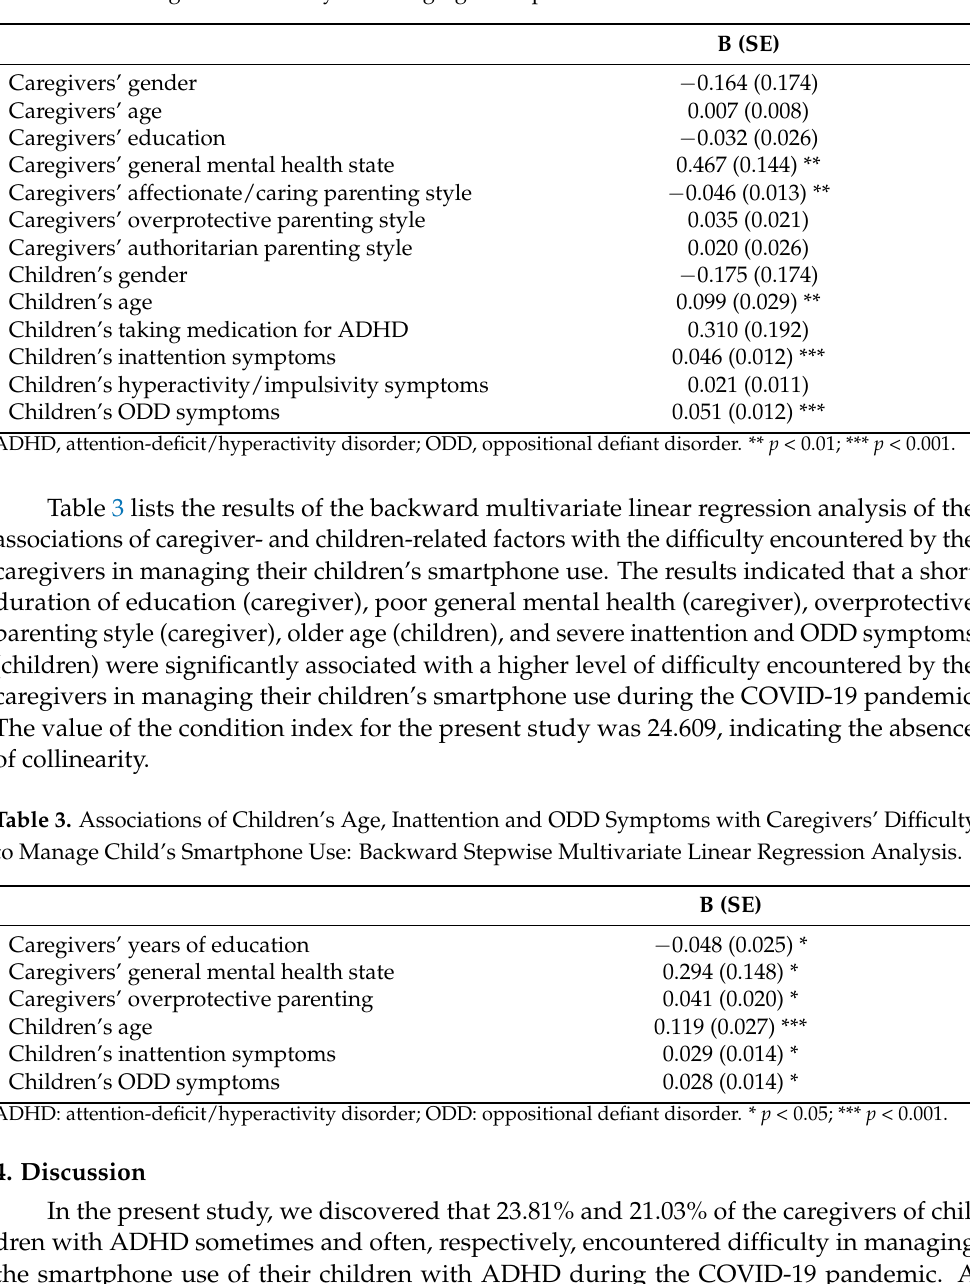
Table 2. Univariate Linear Regression Analysis of Associations of Caregiver- and Children-Related Factors with Caregivers’ Difficulty in Managing Smartphone Use of Children.